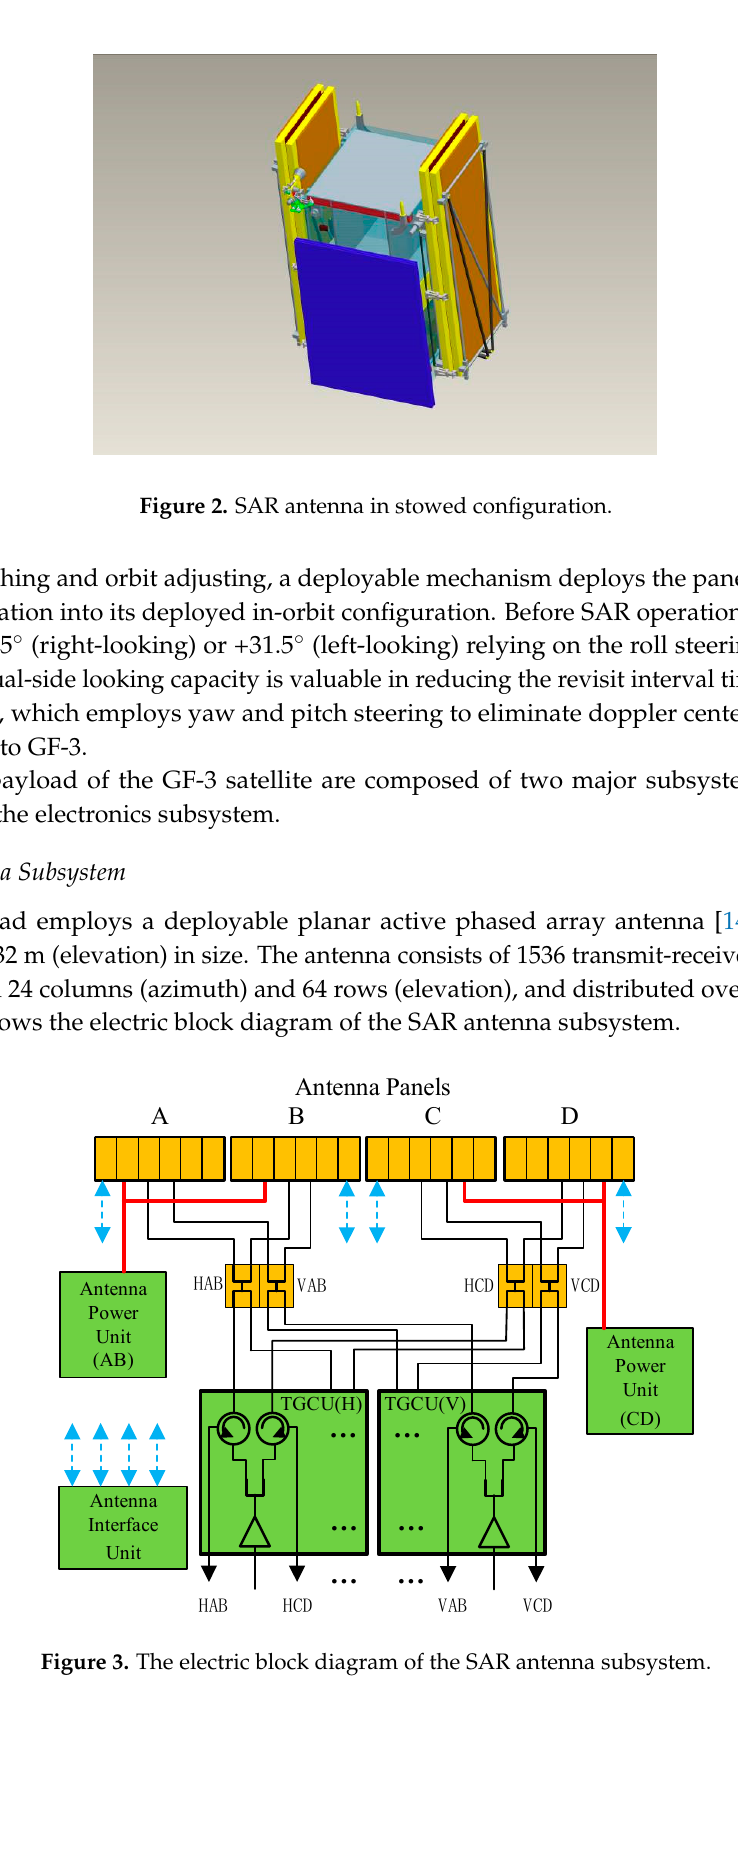
Figure 3. The electric block diagram of the SAR antenna subsystem.